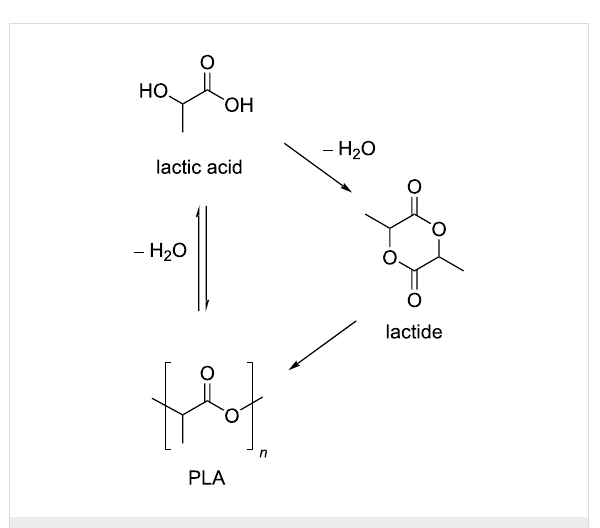
230 °C reaction temperature. Isosorbide is a safe chemical [246]